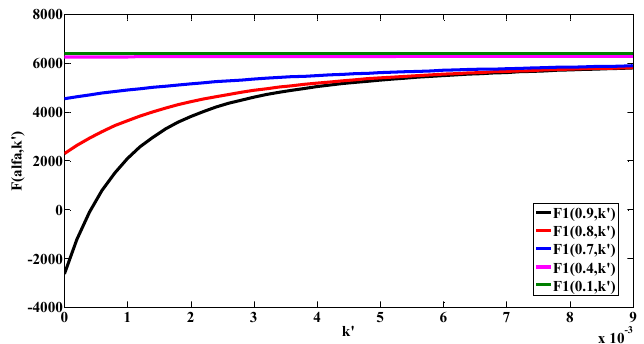
Figure 8. Trend of the function as k’ and α (0.1 to 0.9) changes.